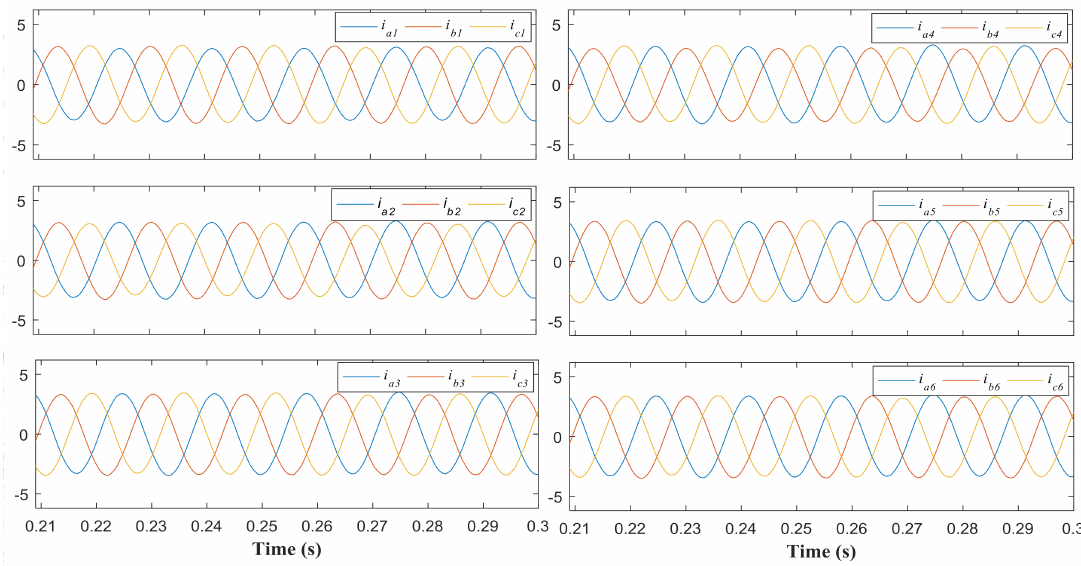
Figure 7. Currents inside the proposed